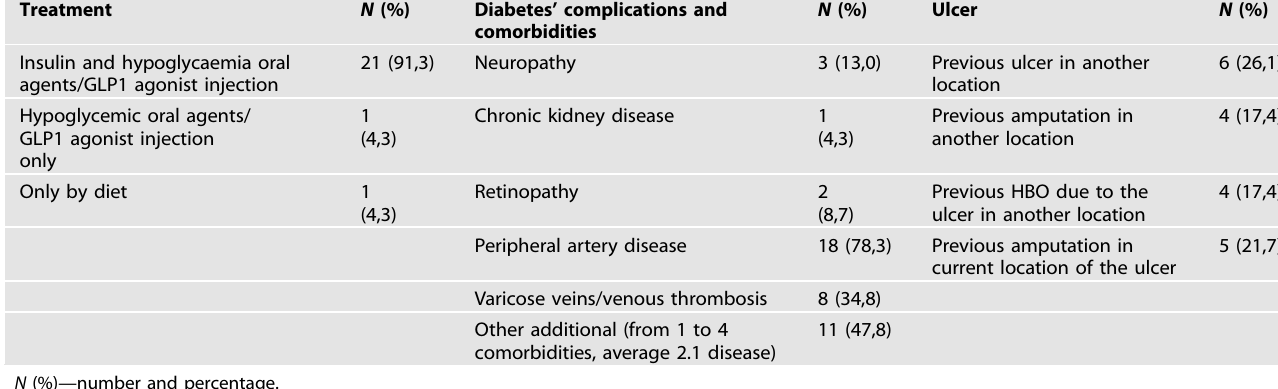
Table 3. Ulcer characteristics in patients with diabetic mellitus and diabetic foot ulcers (Group D). The current location of the ulcer N (%) Ulcer stage according to The University of Texas Diabetic Foot Ulcer Classi fi cation System Class Before HBOT N (%) After HBOT N (%) Before HBOT Lower leg Foot 15 (65.2) Foot and toes 5 (21.7) Toes 2